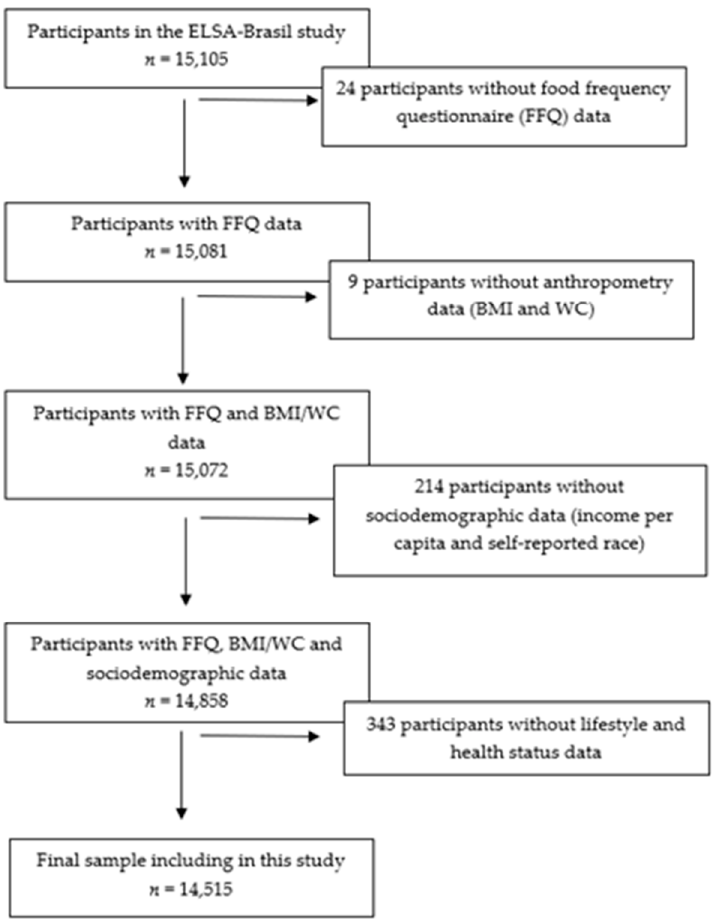
Figure 1. Flow chart of the sample included in the study process. ELSA-Brasil,